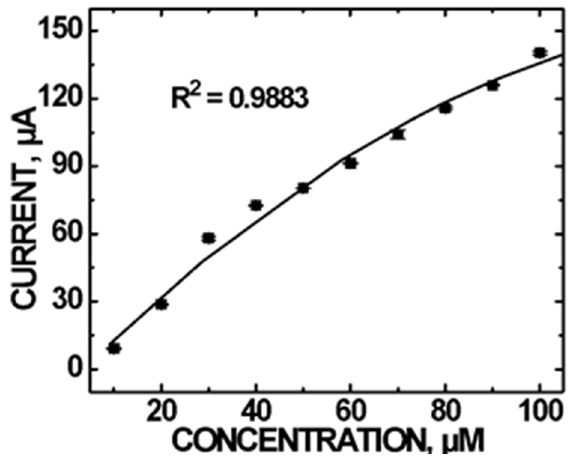
Figure 4. CV current vs DA concentrations using the CoO/COOH-MWNT/GCE sensor at +0.300 V in the concentration range of (10–100) µM at pH 5.0. Error bars are smaller than the symbols.